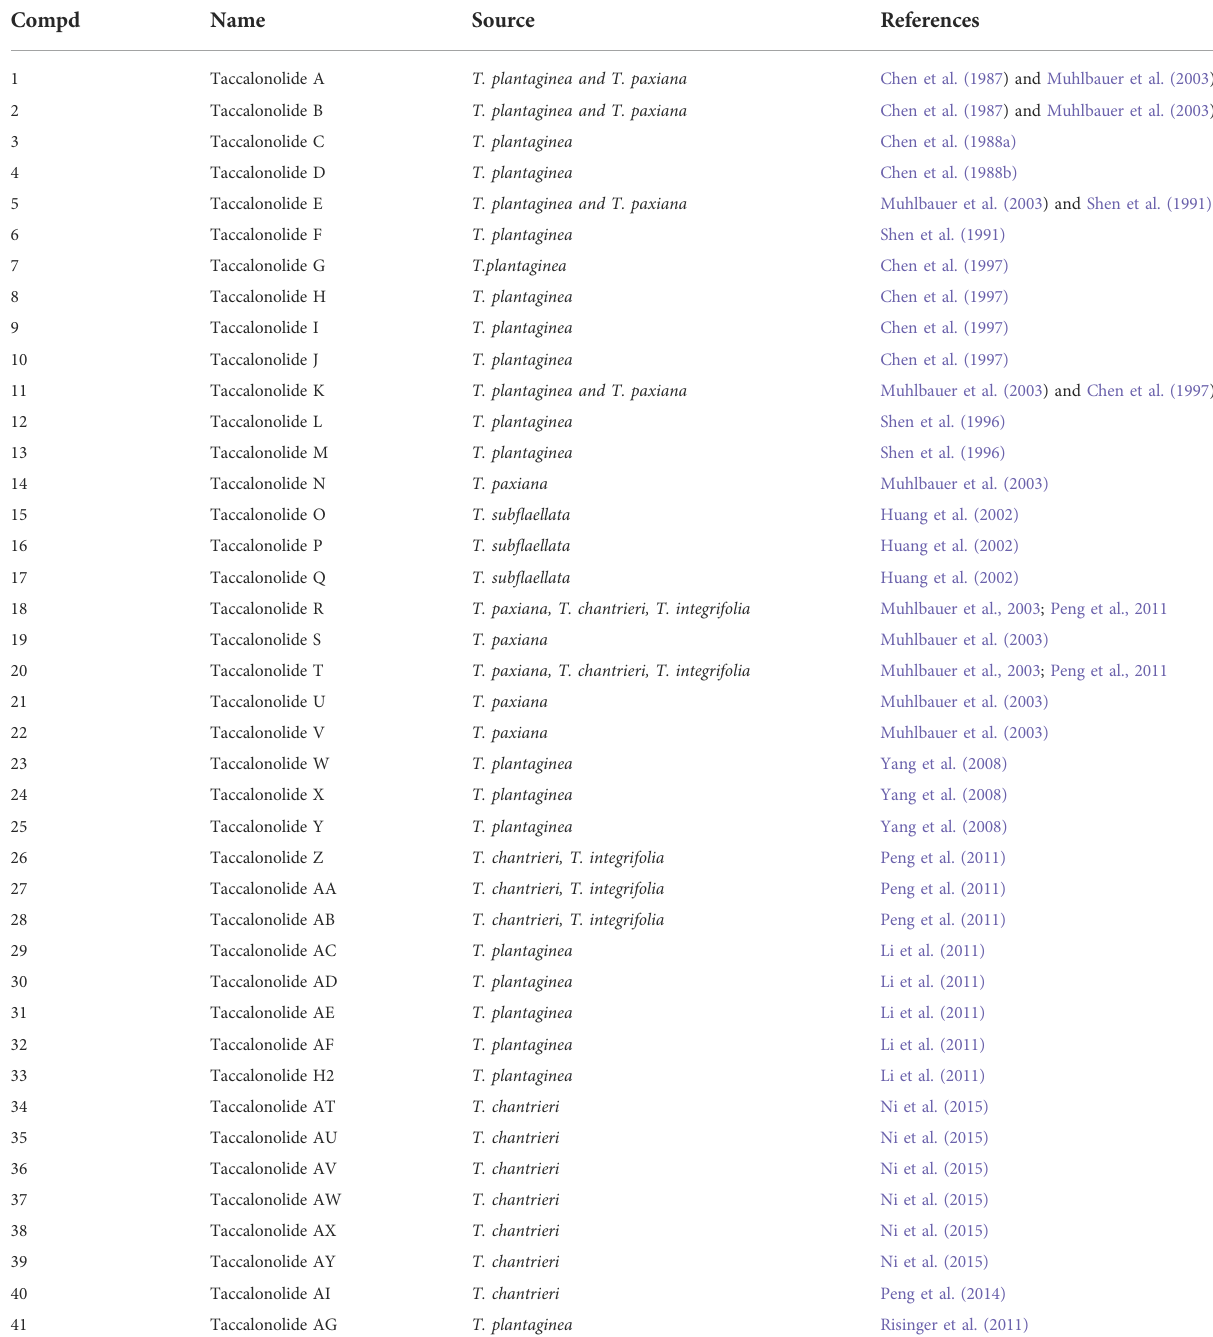
TABLE 1 The name and source of natural